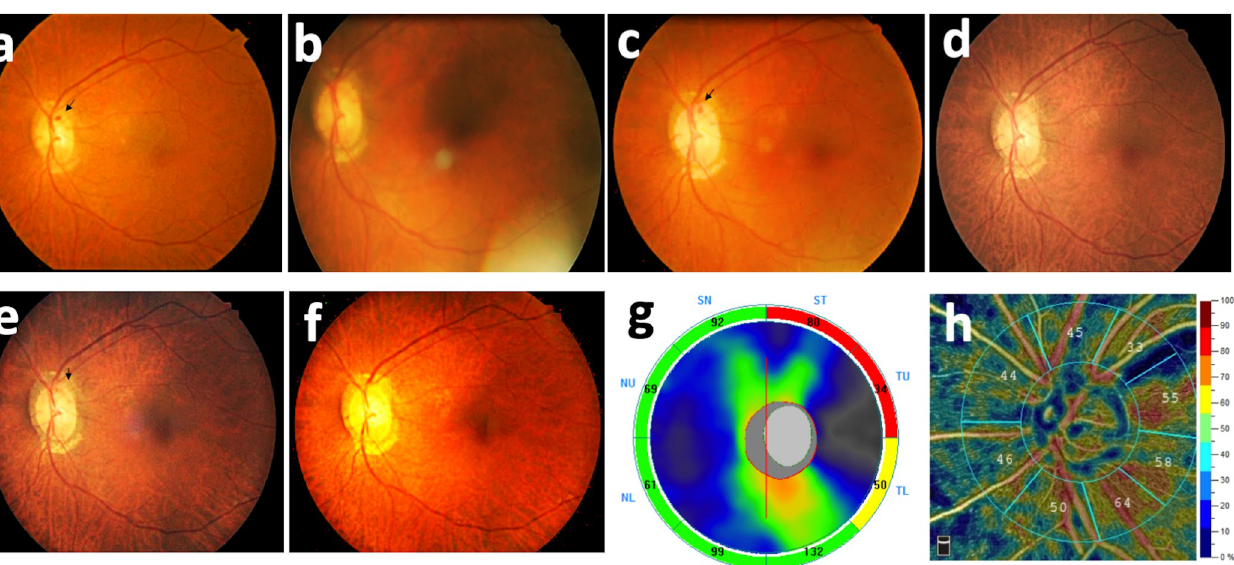
PLOS ONE | https://doi.org/10.1371/journal.pone.0237796 August 17,